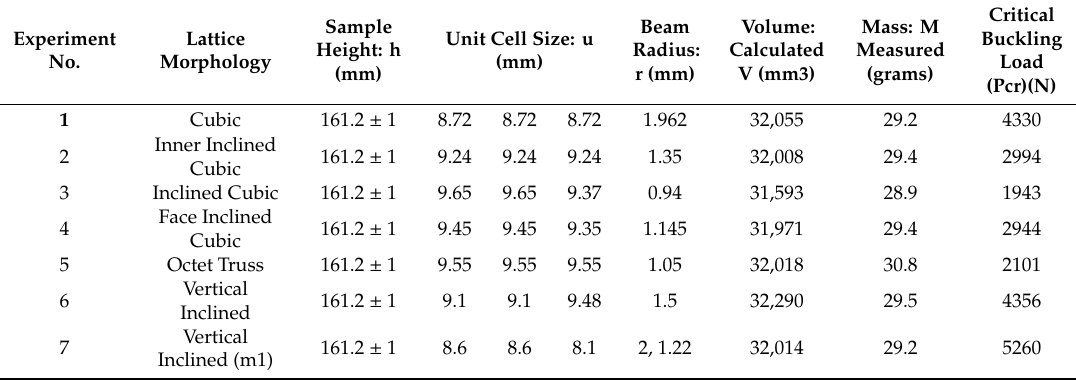
Table 3. Design of experiment, parameters of samples, and